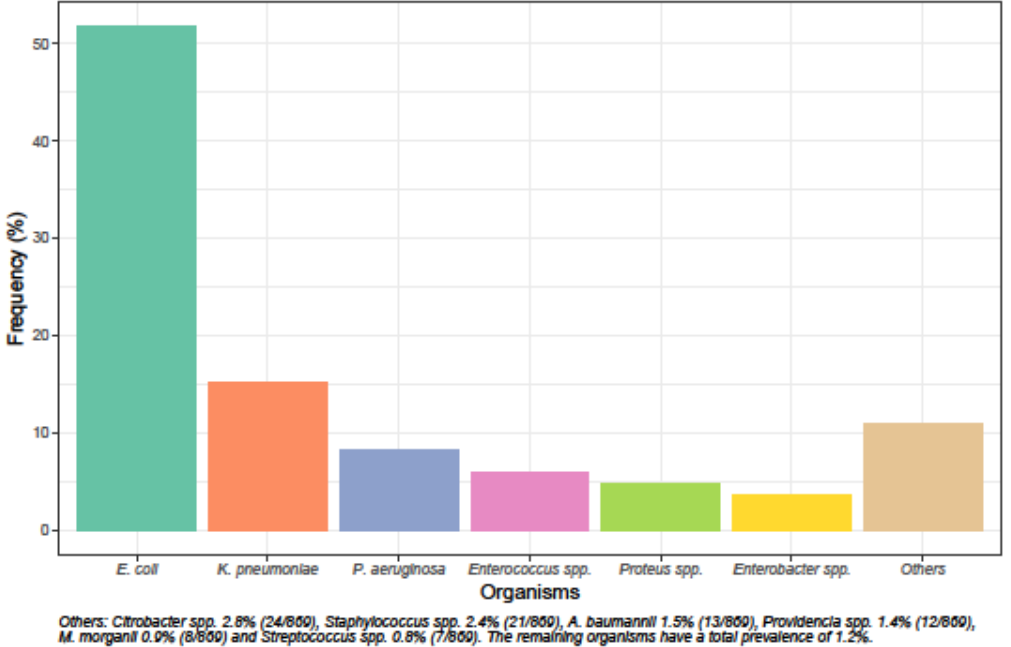
Figure 1. Species distribution of uropathogens.